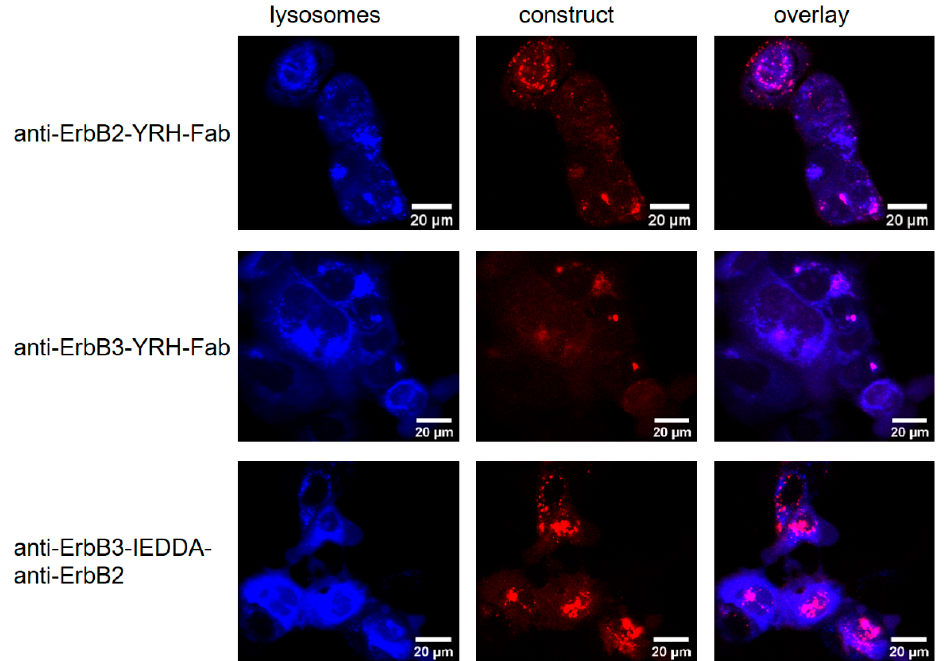
Figure 7. Internalization of anti-ErbB3-IEDDA-anti-ErbB2-bsFab compared to the single anti-ErbB2- and anti-ErbB3-Fab by lysosome-stained HCC-1954 cells after 24 h. Lysosomes were stained with LysoBriteBlue, single and bispecific Fabs were modified with AlexaFluor568 NHS ester. IEDDA: inverse electron-demand Diels–Alder reaction.